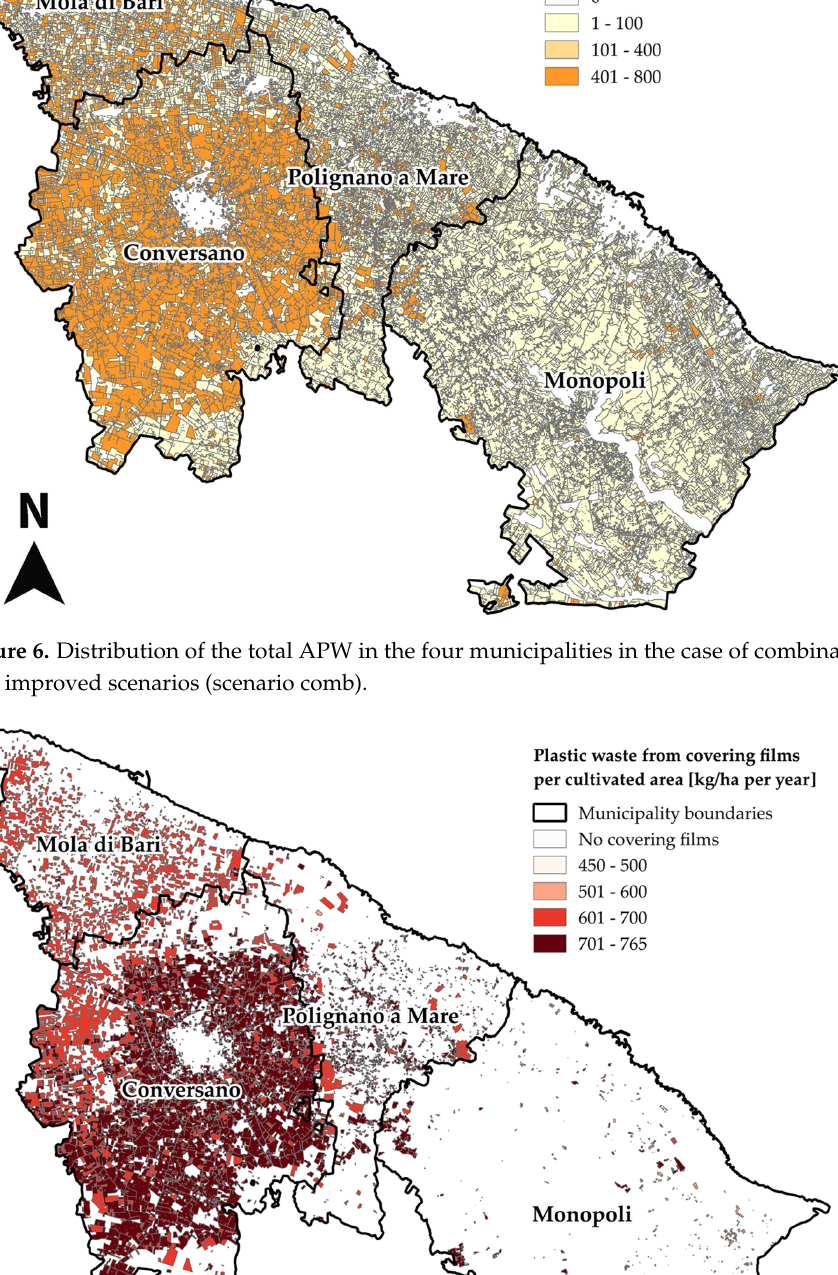
Figure 5. Distribution of the total APW in the four municipalities in the scenario of partial replace- ment of some of the plastics with bio-based materials (2nd scenario).